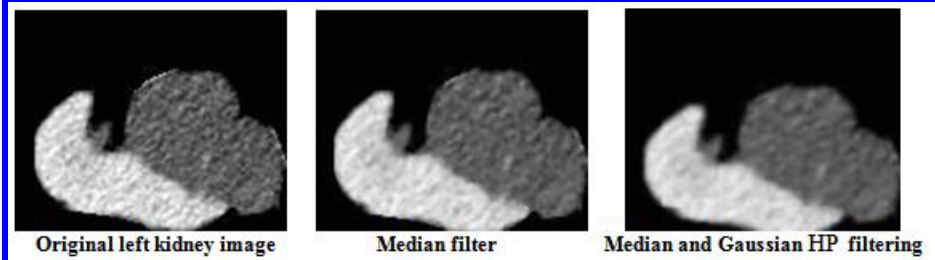
Fig. 4: Pre-processing technique after applied median and Gaussian HP